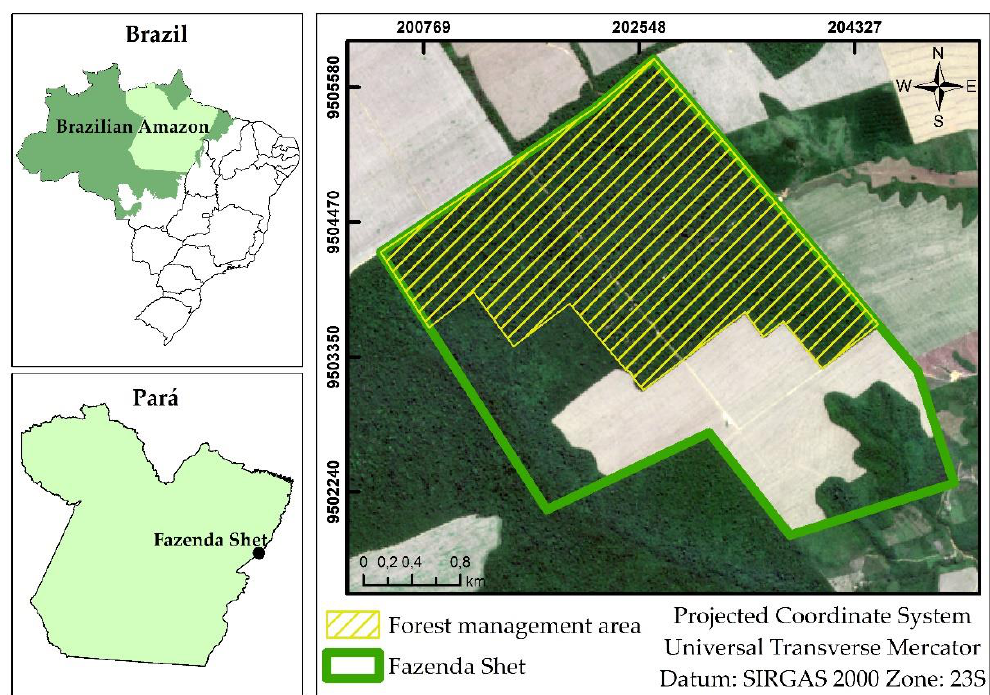
Figure 1. Forest management area of Fazenda Shet, Dom Eliseu, State of Pará, Brazil.